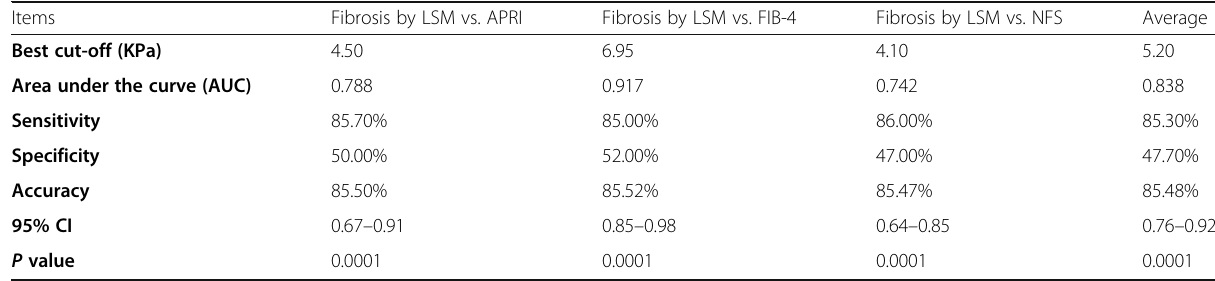
Table 4 Sensitivity, specificity, and accuracy for fibrosis by TE (LSM) and non-invasive assessment scores